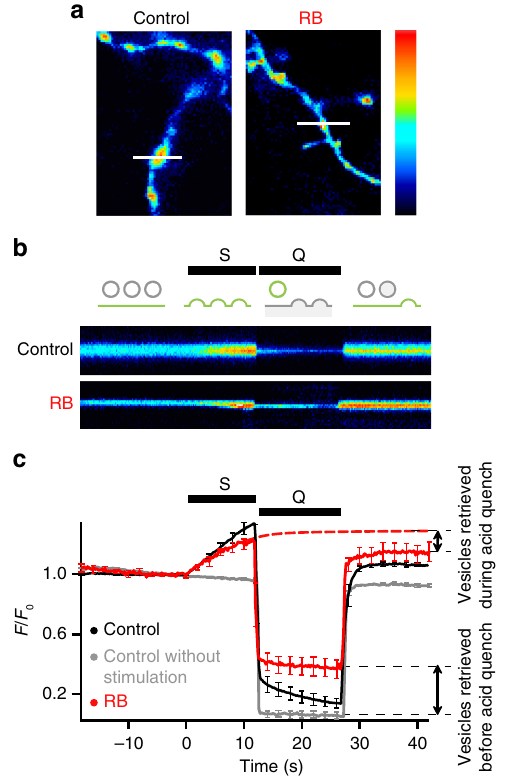
Fig. 6 Time course of SV acidi fi cation. a SpH fl uorescence of axons and presynaptic terminals after stimulation (12 s, 20 Hz) in control conditions or after 5 min incubation with 100 nM RB. Lines represent the position of the scan lines in b . b Line-scan time series of single boutons. S: fi eld electrical stimulation, Q: rapid surface quenching by application of impermeant acid (pH 5.25) immediately after end of stimulation. Pseudo-colour scale bars a , b are linear, with black indicating zero fl uorescence. Schematic shows the fl uorescence of three SVs recaptured at different rates: before, during and after acid quench (from left to right) in control conditions. c Average SpH responses without ( n = 10) or with stimulation in absence ( n = 11) or presence ( n = 6) of RB. Red dashed line represents the average SpH response in presence of RB, without acid quench. Time scale is the same in b and c . Error bars represent s.e.m. They are shown every tenth point (2 s) for better